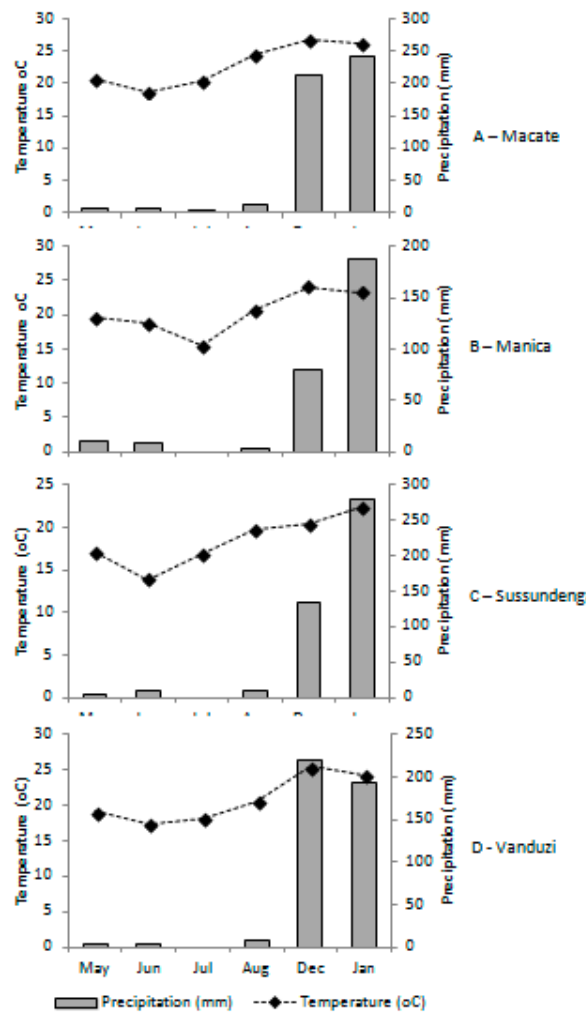
Figure 2. Monthly mean temperatures (°C) and mean precipitation (mm) in the districts of Macate, Manica, Sussundenga, and Vanduzi in the dry season (May to August) and in the rainy season (December and January).